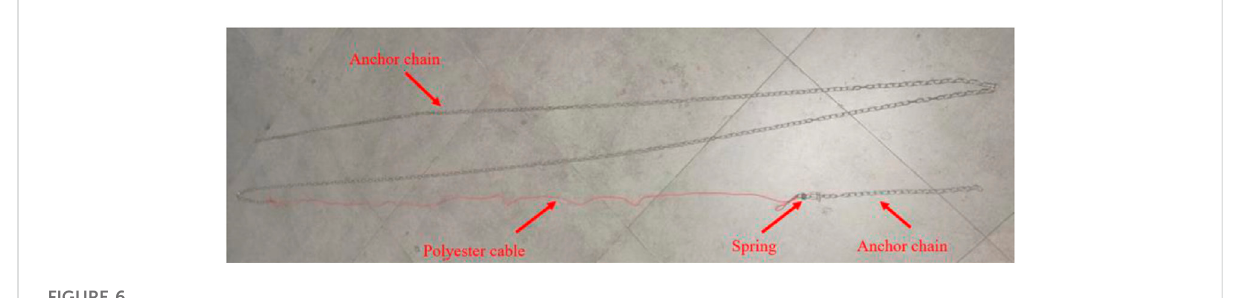
FIGURE 6 The model of hybrid mooring cable scheme.